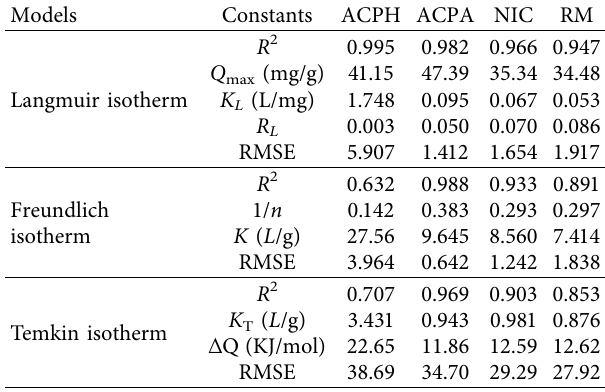
Table 5: Results of adsorption parameters for the different iso- therm